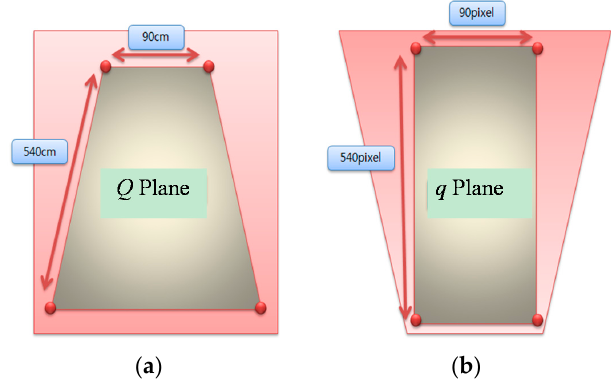
Figure 2. ( a ) Original image; ( b ) Air view image of ( a ).